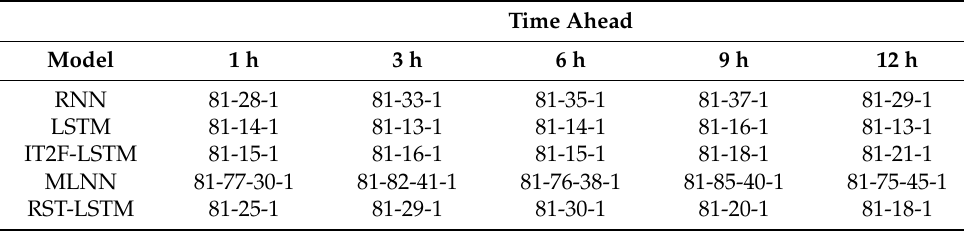
Table 3. The best structures of the prediction models having lowest